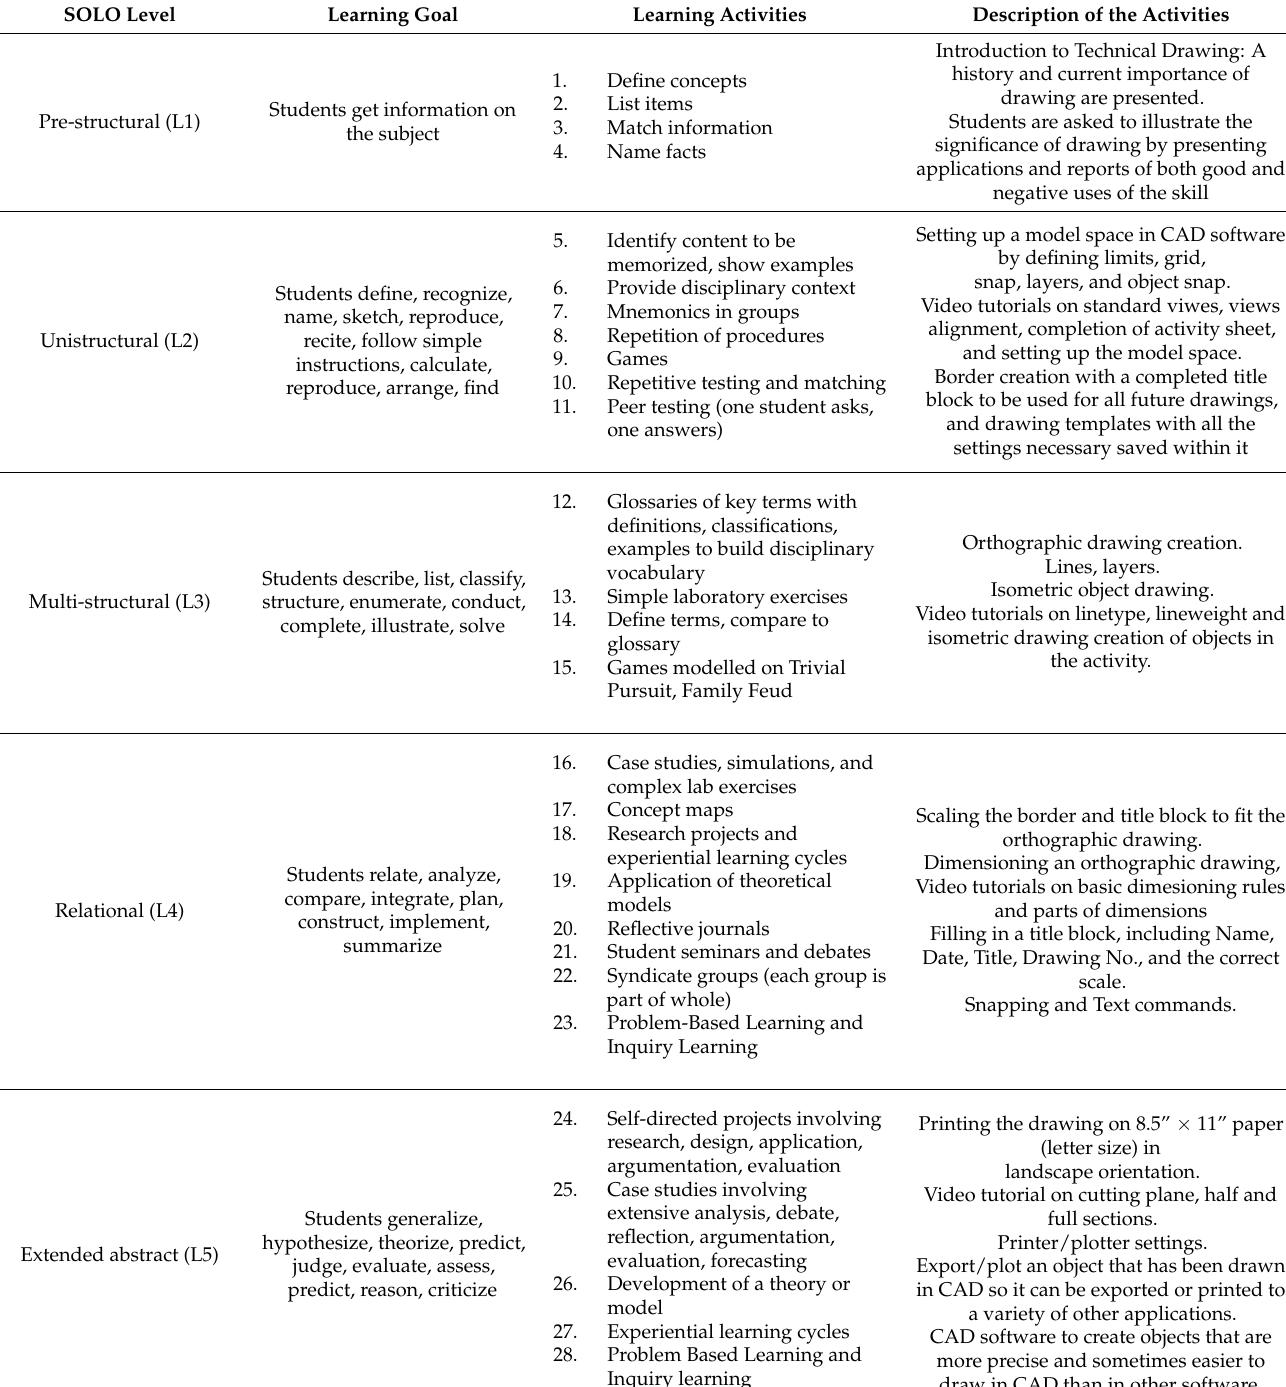
Table 1. Learning goals and activities per SOLO level